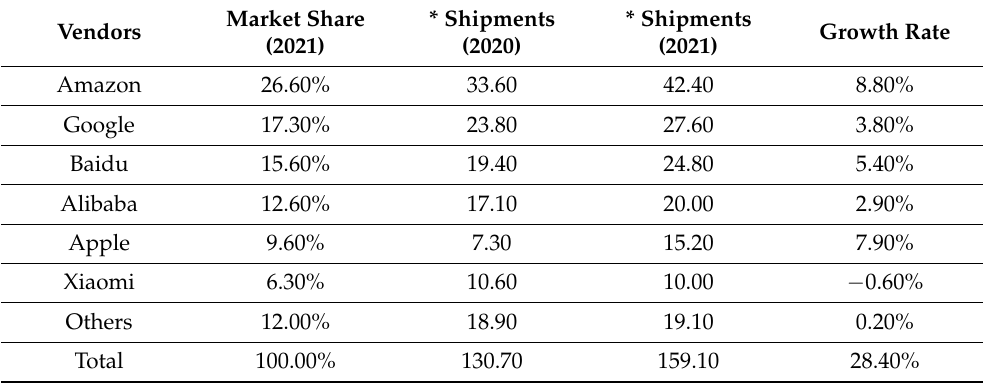
Table 1. Artifical Artificial intelligence speaker market forecast by [9].